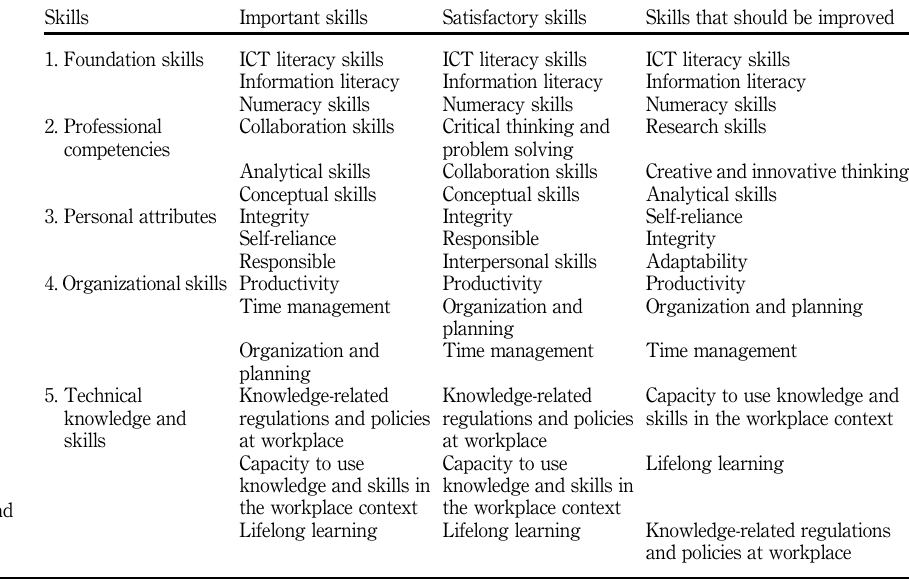
Table IX. Prominent skills and qualities for HOU